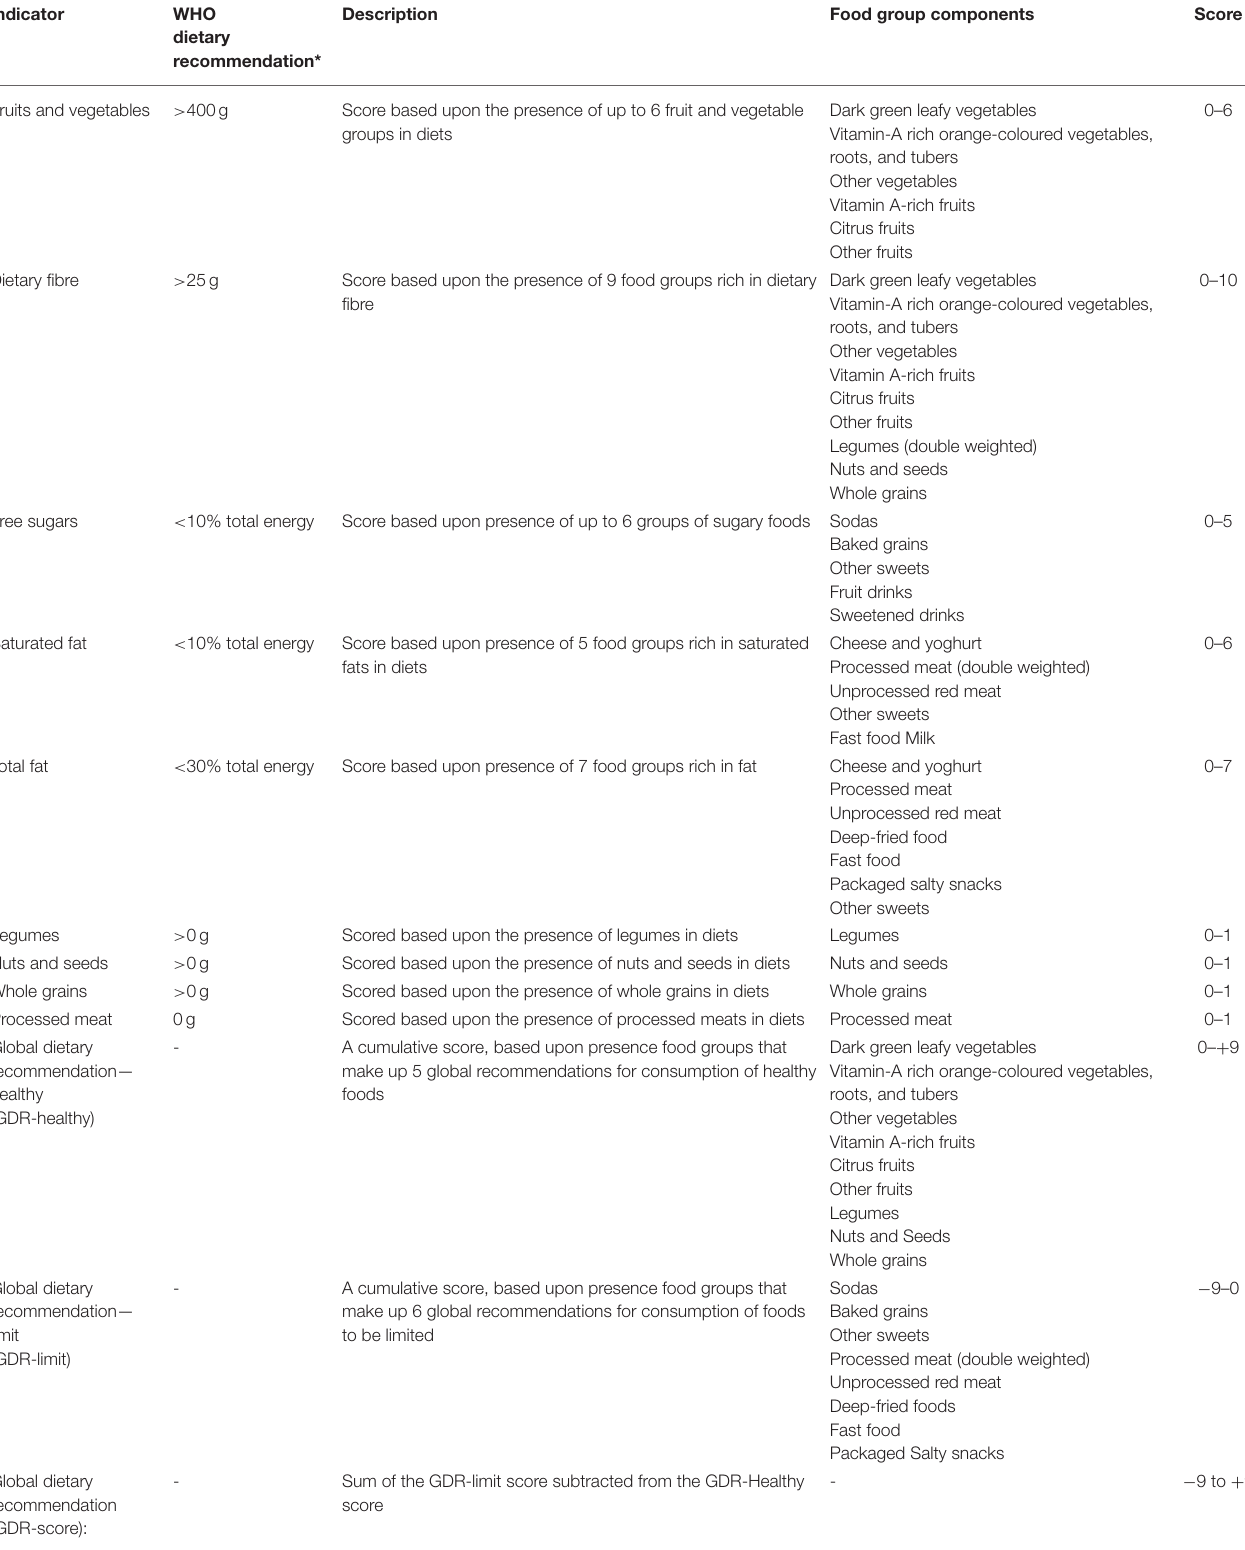
TABLE 1 | Diet quality questionnaire indicators.